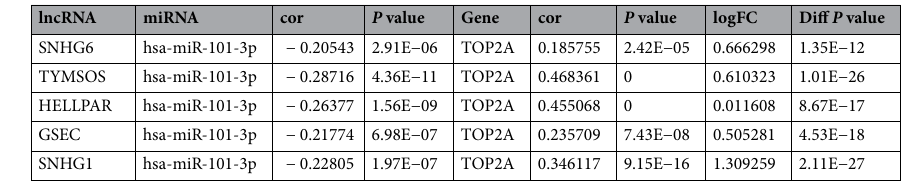
Table 4. The lncRNAs were significantly negatively correlated with miR-101-3p in LUAD, and their expression in LUAD and control